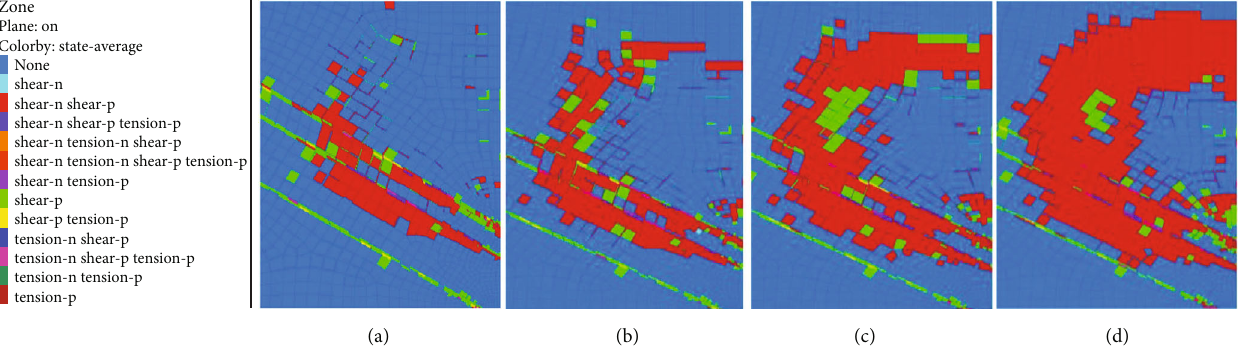
Figure 17: The plastic zone change of roadway roof in 302 mining area when the cutting position is 340m ahead of schedule. (a) Working face advancing 40m; (b) working face advancing 80 m; (c) working face advancing 120m; (d) working face advancing 160 m.